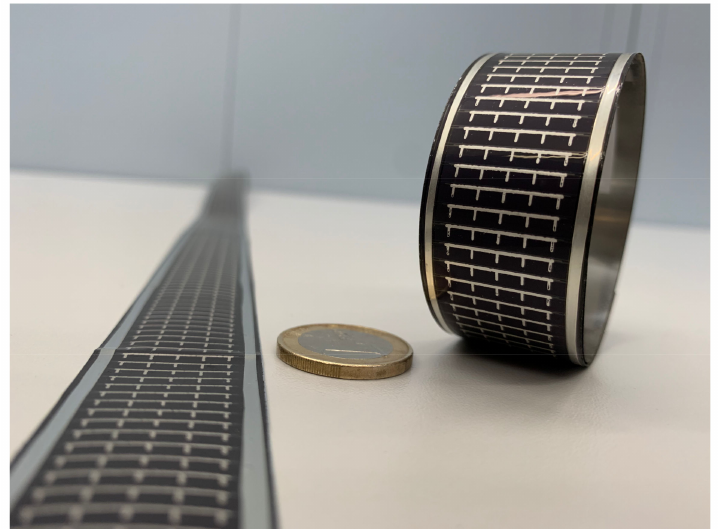
Figure 3. PTS sample with a length of 1.5 m on the left; submodule with a length of 25 cm on the right; the total thickness of the samples is 103 µ m (including lateral busbars); a submodule consists of 80 serially connected strings of four parallelized cells each.